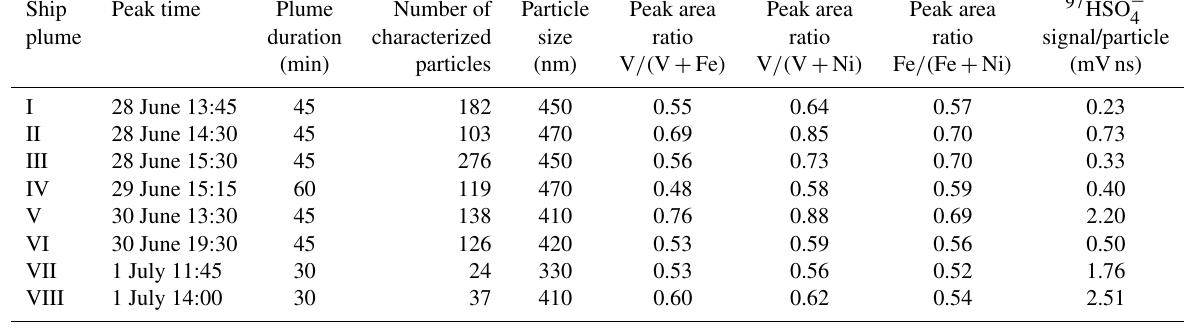
Table 2. Ship plumes according to Figs. 3, 4 and 5, their main properties as well as the median of relative signal ratios for metals and sulfate signals.